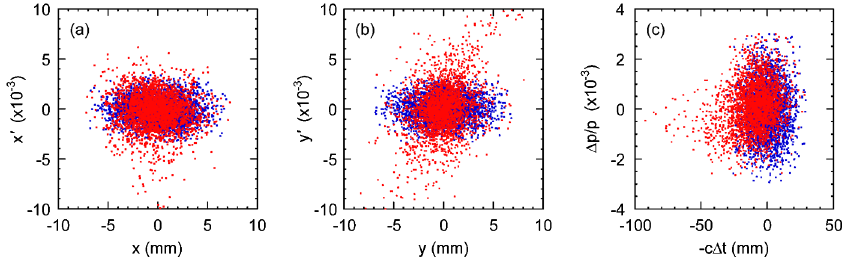
FIG. 7. Horizontal (a), vertical (b), and longitudinal (c) phase-space distributions of a 1 : 2 GeV =c muon bunch before (blue) and after (red) passing through the droplet